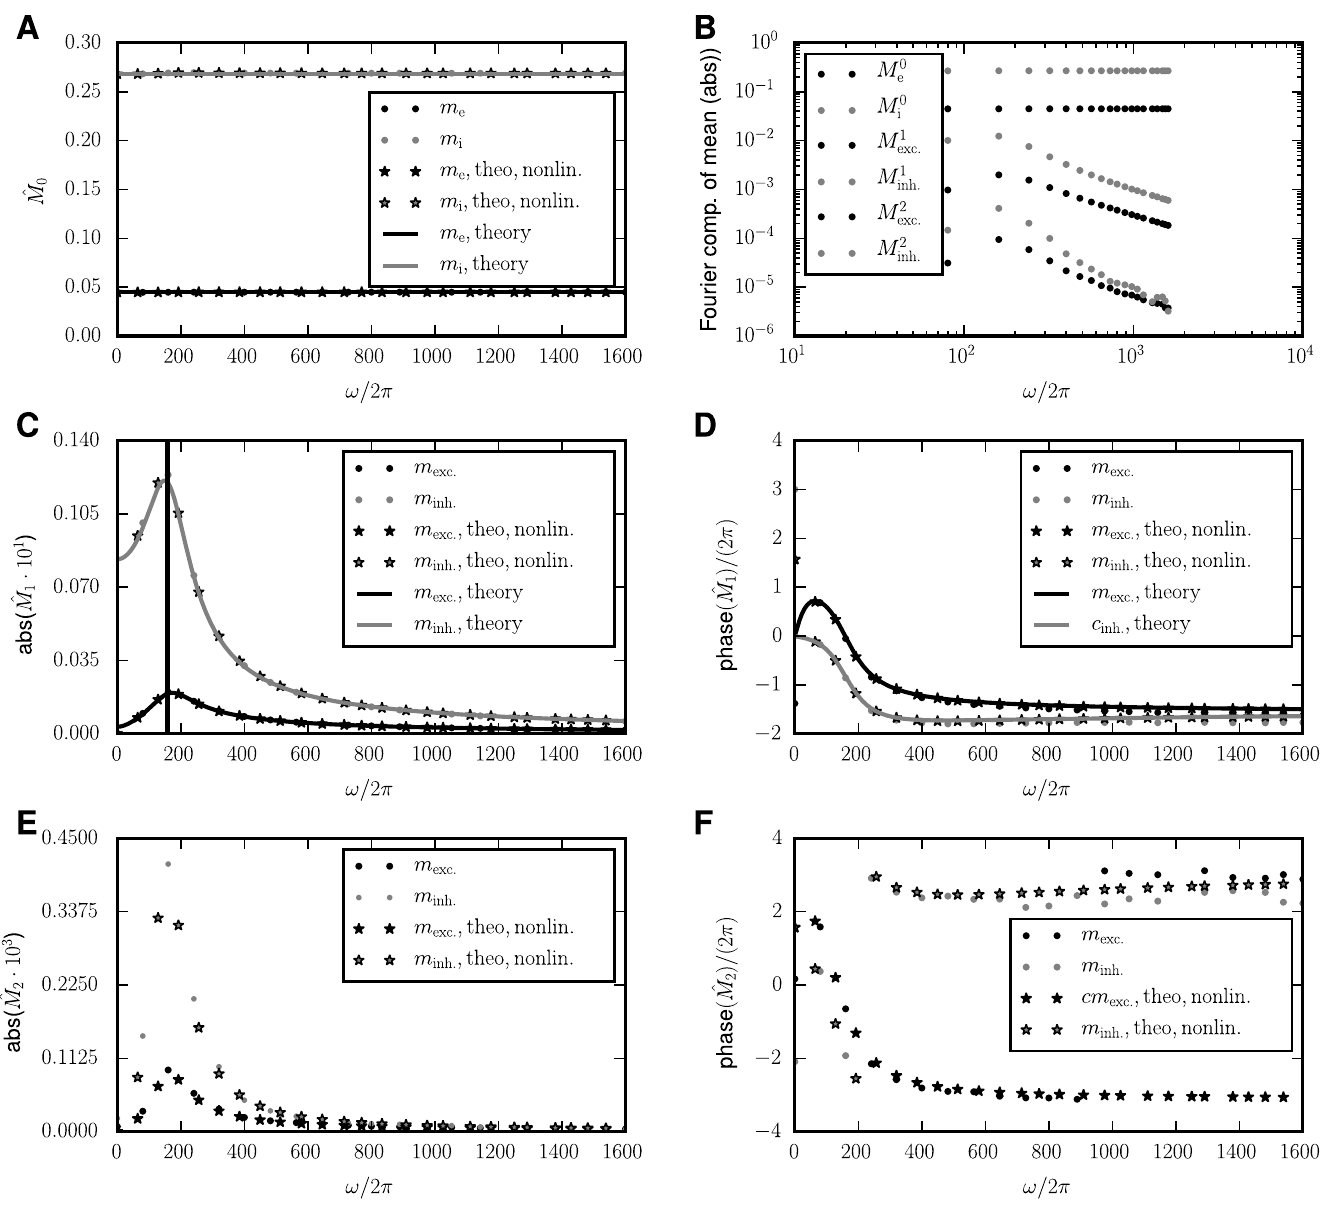
Fig 5. Driven E-I network with biologically inspired parameters: Mean activity. From the first to the third row, the zeroth to second Fourier mode of the mean activity is shown. A Constant part of mean activity (zeroth order). B First three Fourier-modes of the mean activitieson a loglog-scale. C Amplitude of first mode of the mean activity. D Phase of first mode relativeto driving signal. E and F are structured analogous to C and D for the second Fourier modes. Solid curves indicatethe linear theory (Eq (9)), stars numerical integrationof the full mean field equations(Eqs (5) and (6)) and dots the simulationresults of the full network. Black symbols indicate the activity of excitatory, gray symbols of inhibitoryneurons. Numericalresults obtainedby the same methods as in Fig 3. Noise amplitudes σ noise, E = σ noise, I = 10, σ network, E = 2.8, σ network, E = 4.6, other parameters of the network model given in Table 1.